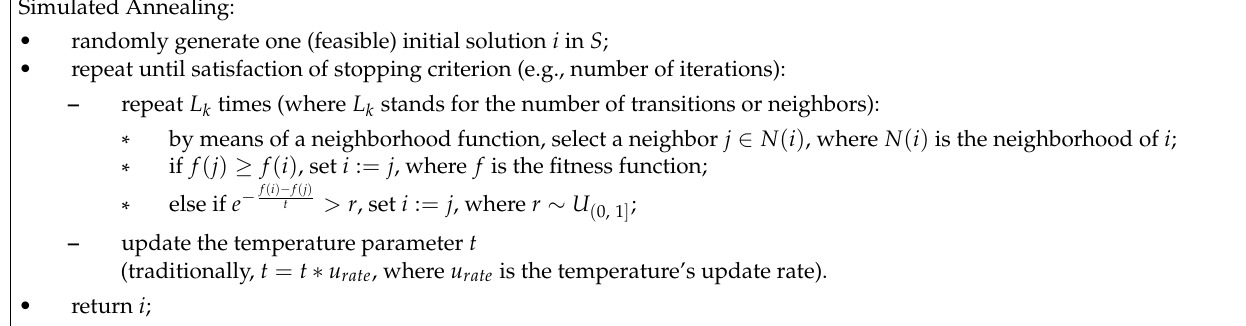
Figure 4. Procedural steps of simulated